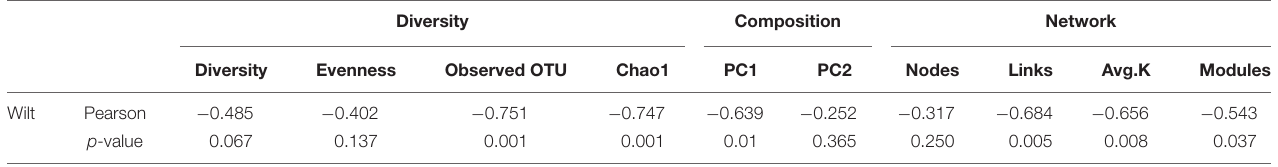
TABLE 1 | Pearson correlation between wilt infection rate and microbial community which are related to microbial community diversity, composition and network properties. Diversity Composition